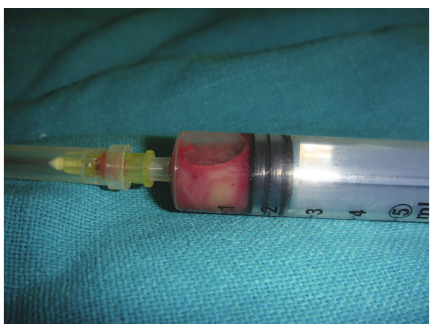
Figure 5: Fine needle aspiration cytology showing straw colored fluid intermixed with